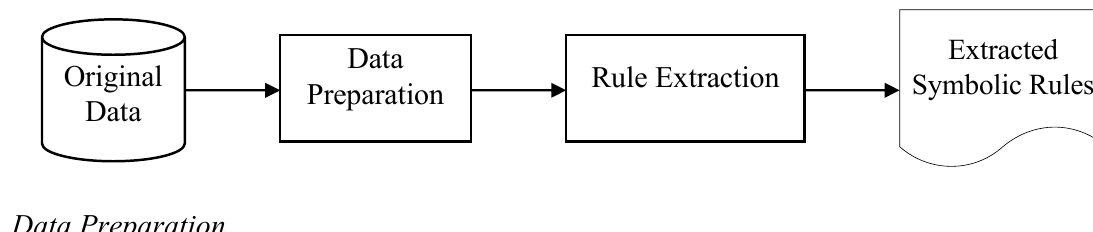
Figure 1. Data mining technique using